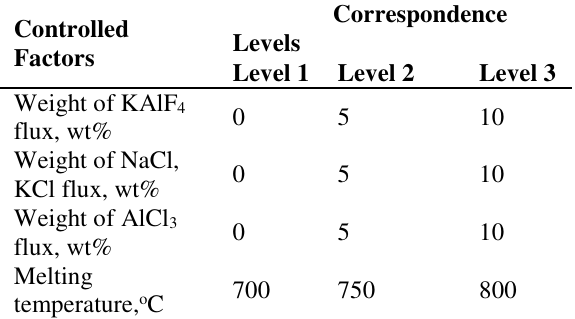
Correspondence Levels